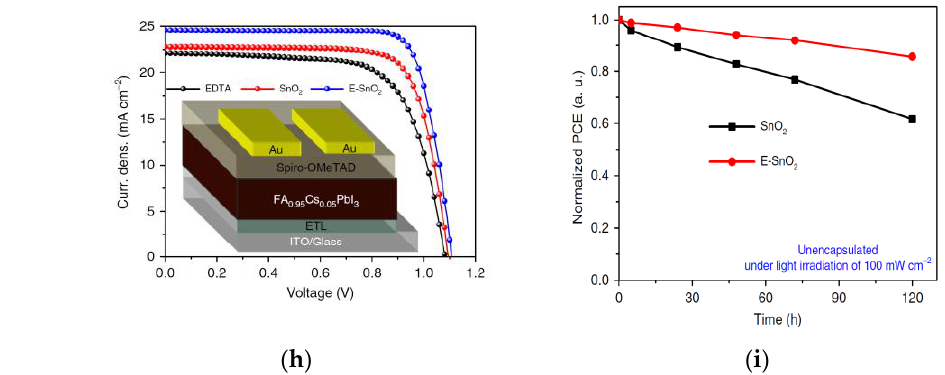
Figure 8. ( a ) Molecular structure of PEGDA. Cross-sectional SEM images of the perovskite on ( b ) undoped SnO 2 and ( c ) SnO 2 doped with PEGDA. Reproduced from [80] with permission from ACS Publications, 2021. ( d ) Cross-sectional SEM image of PSC device with SnO 2 doped with 2,2,2-trifluoroethanol (T-SnO 2 ). ( e ) Illuminated J - V curves under 1 SUN for forward and reverse scans of SnO 2 and T-SnO 2 based devices. ( f ) Long-term stability measurements of unencapsulated devices in air with 30 – 40% relative humidity for SnO 2 , T-SnO 2 , and oxygen plasma-treated T-SnO 2 (p-T-SnO 2 ) as ETLs. Reproduced from [81] with permission from Cell Press, 2019. ( g ) Fermi levels of EDTA, SnO 2 , and EDTA:SnO 2 relative to the conduction band of the perovskite layer. ( h ) Illuminated J - V curves of PSC devices with various ETLs. ( i ) Long-term stability measurements of unencapsulated devices with different ETLs under 1 SUN illumination. Reproduced from [82] with permission from Springer Nature, 2018.